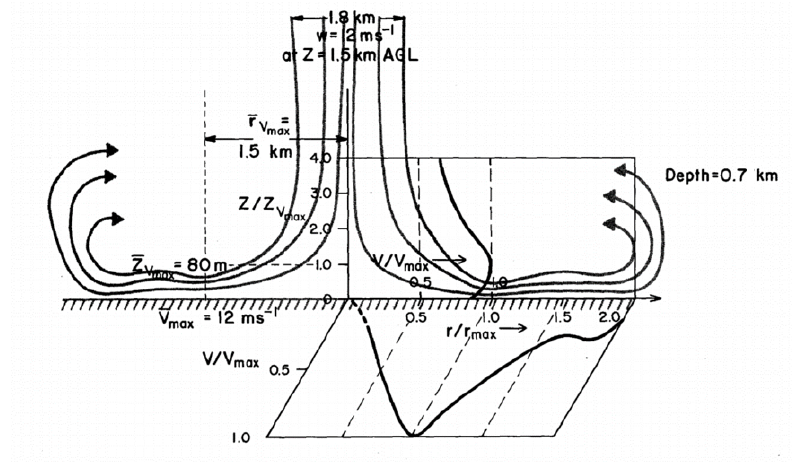
Figure 2. Scheme of a thunderstorm downburst and nose velocity profile in the radial outflow (adapted from Hjemfelt,